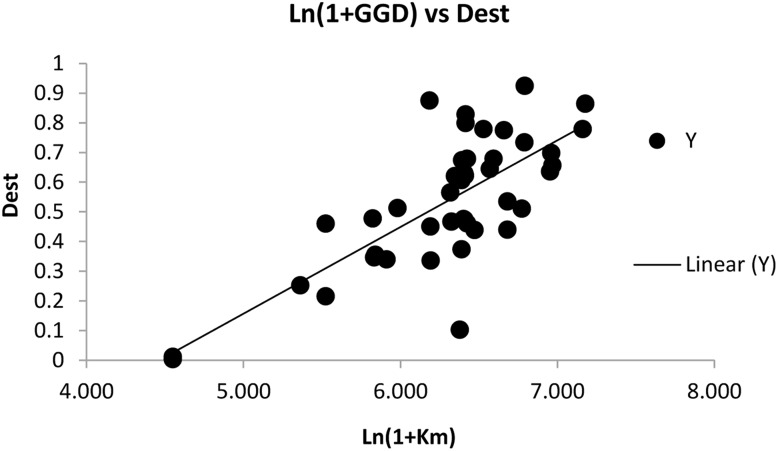
Relationship between Dest and geographic distance Ln(1+km) at population level.